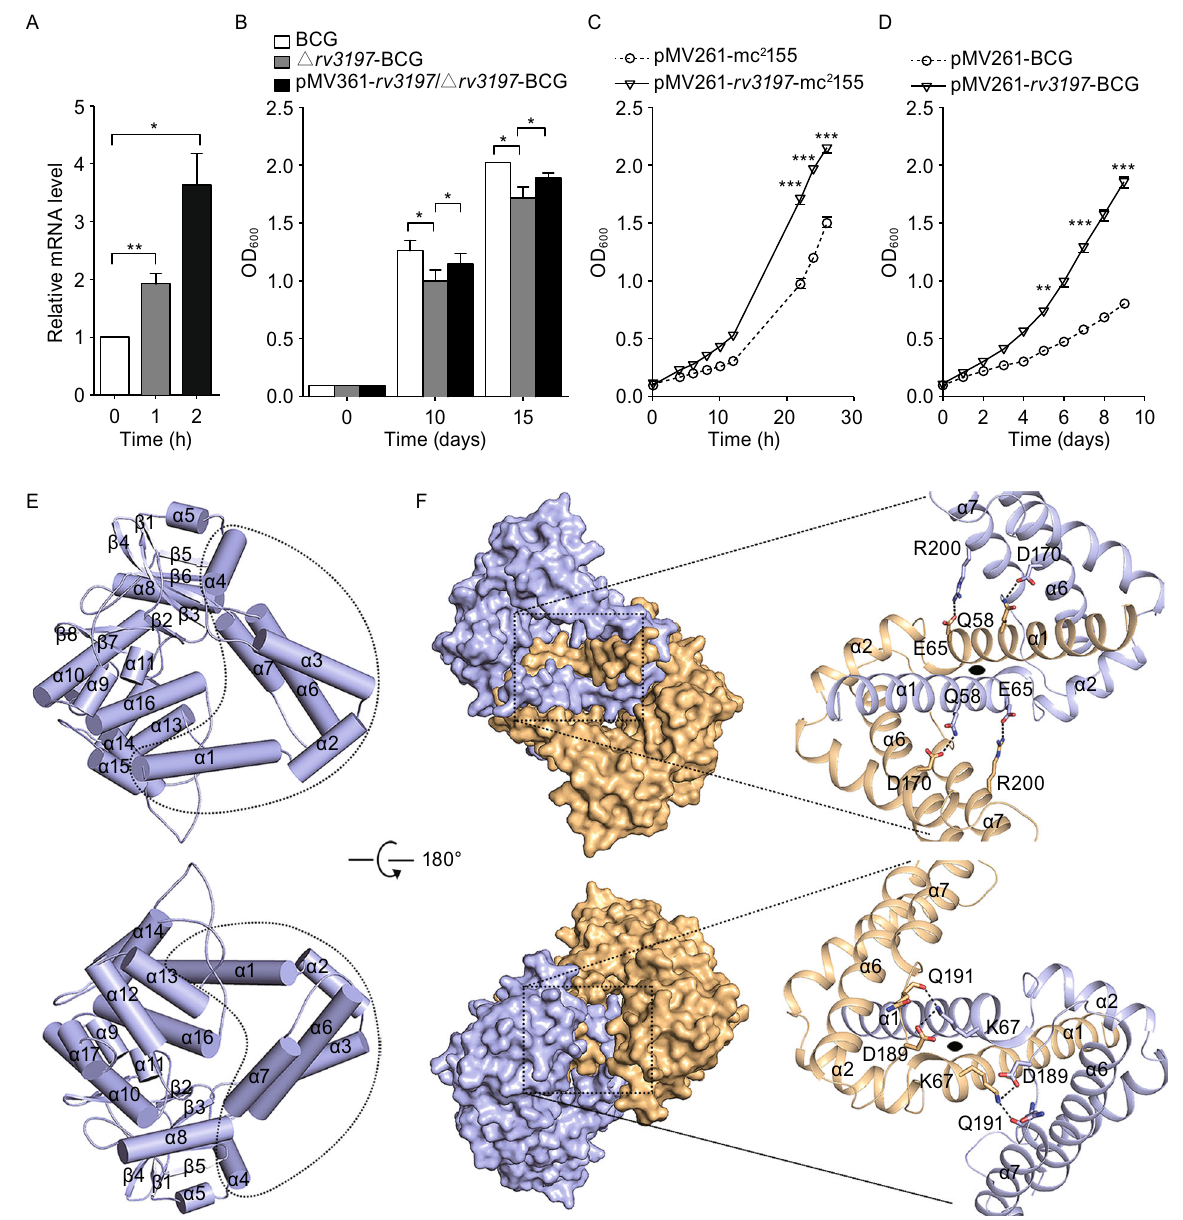
Figure 1. The functional and structural studies of Rv3197 (MABP-1) . MABP-1 confers inducible resistance to erythromycin in mycobacteria (A – D). (A) mRNA levels of rv3197 in BCG determined by qRT-PCR after treatment with 6 mg/L erythromycin. (B) The growth of wild type BCG, Δ rv3197 -BCG and pMV361 -rv3197 / Δ rv3197 -BCG in 7H9 medium in the presence of 2 mg/L erythromycin. (C) Growth curves of pMV261-mc 2 155 and pMV261 -rv3197 -mc 2 155 in 7H9 medium in the presence of 3 mg/L erythromycin. (D) Growth curves of pMV261-BCG and pMV261 -rv3197 -BCG in 7H9 medium in the presence of 4 mg/L erythromycin. All results are shown as the mean ± standard deviation of three individual experiments. * P < 0.05, ** P < 0.01, *** P < 0.001. The crystal structure of MABP-1 (E – F). (E) The domain arrangement of a MABP-1 monomer. The accessory domain is encircled by the dashed outline. (F) Left, surface representation of the MABP-1 dimer. Right, the dimer subunit interface. Each subunit is coloured differently. The α 1 and α 2 helices from each subunit insert into each other ’ s accessory domain. The black oval represents a two-fold axis perpendicular to the given view. Hydrogen bonds are shown as thick dashed gene (pMV261- rv3197 -mc 2 155) has a growth advantage pMV261- rv3197 construct also showed a growth advantage over M . smegmatis that has an empty pMV261 vector over wild type in the presence of 4 mg/L of erythromycin (pMV261-mc 2 155) (Fig. 1C). Likewise, the M . bovis BCG (Fig. 1D). In contrast, no growth difference was detected